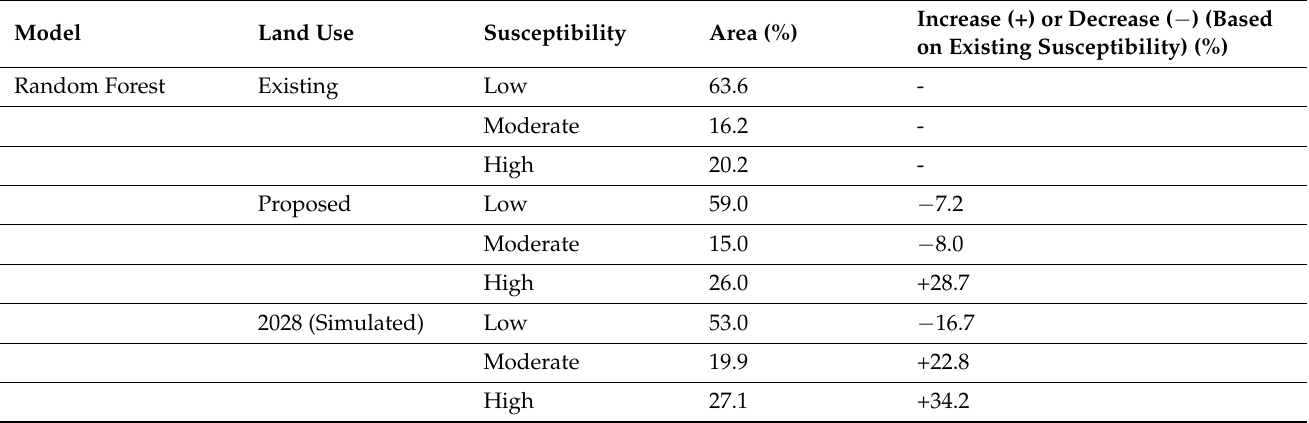
Table 4. Percentage of area under different susceptibility zones.